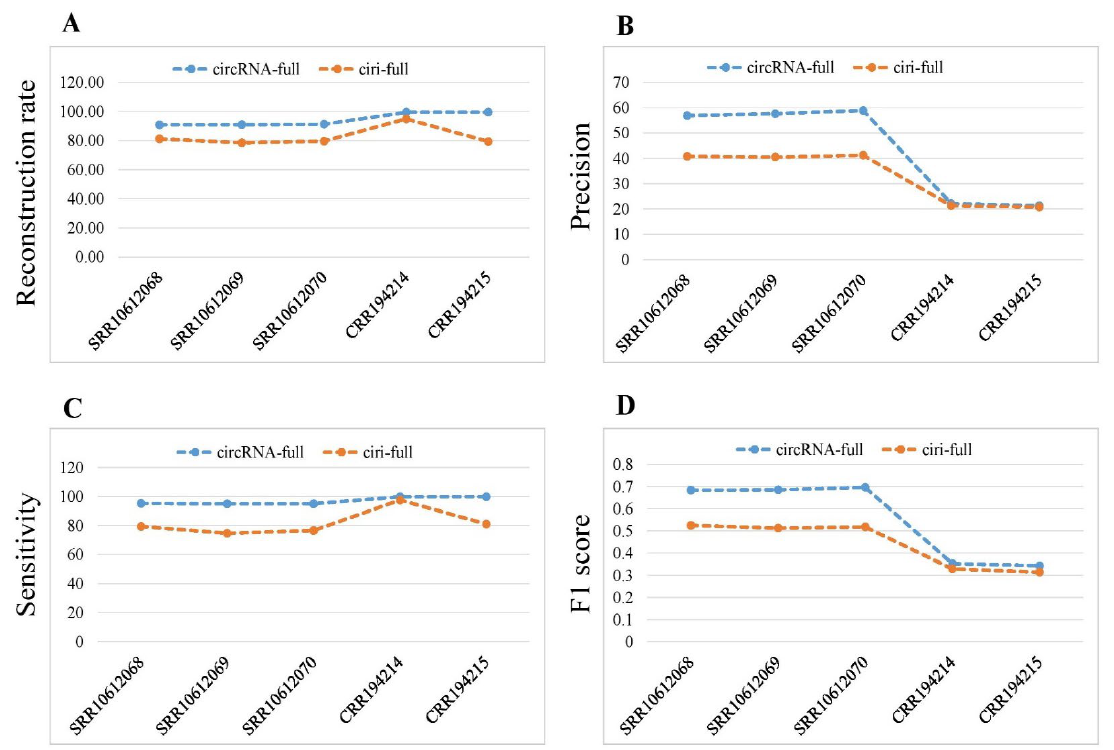
Figure 4. Performance comparison of circRNA-full and ciri-full. ( A ) Reconstruction rate. ( B ) Precision. ( C ) Sensitivity. ( D ) F1 score for different samples.